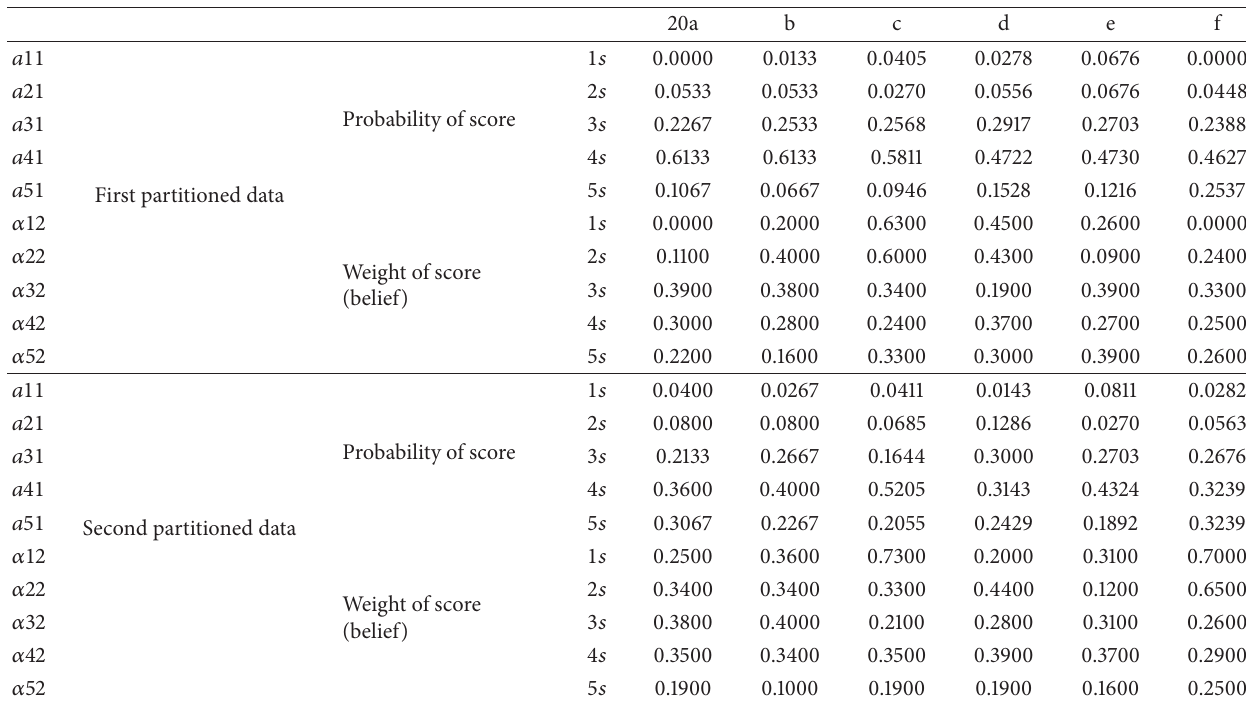
Table 3: Steps 1 and 2 of the algorithm applied to survey question